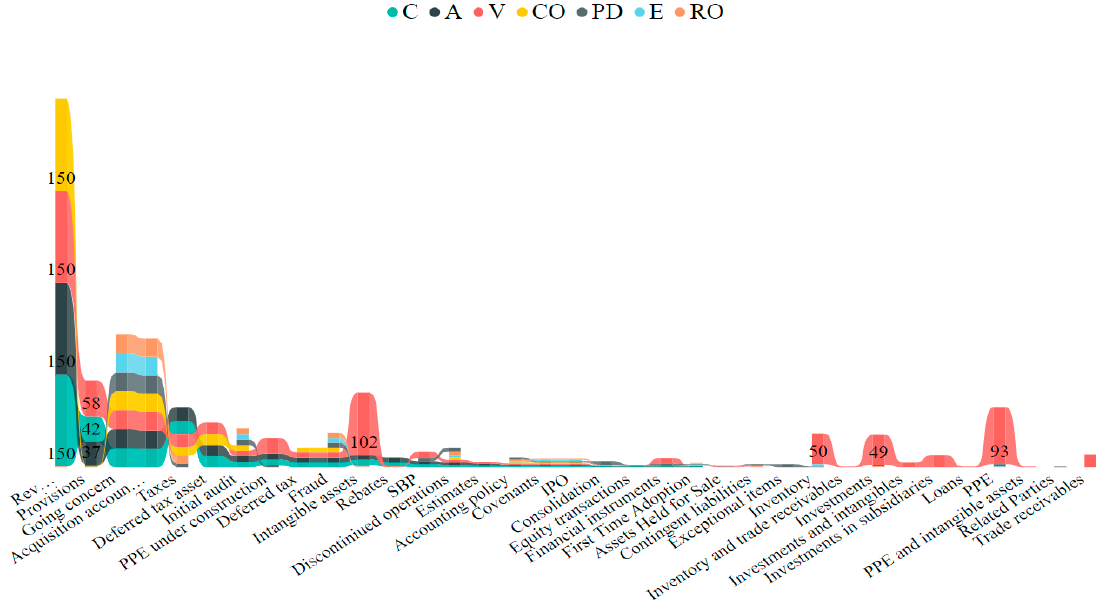
Figure 6. KAM—mapping to assertions. Source: own elaboration based on analyzed data.